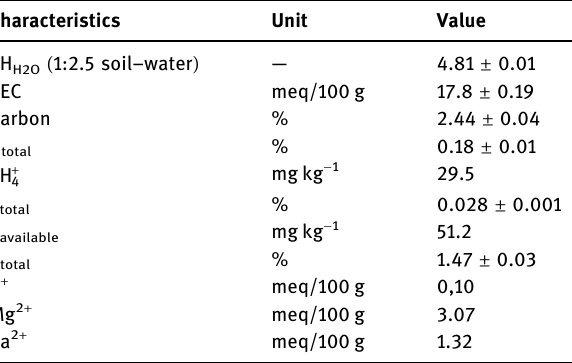
Table 1: Initial physical and chemical characteristics of the soil ( 0 – 20 cm depth )